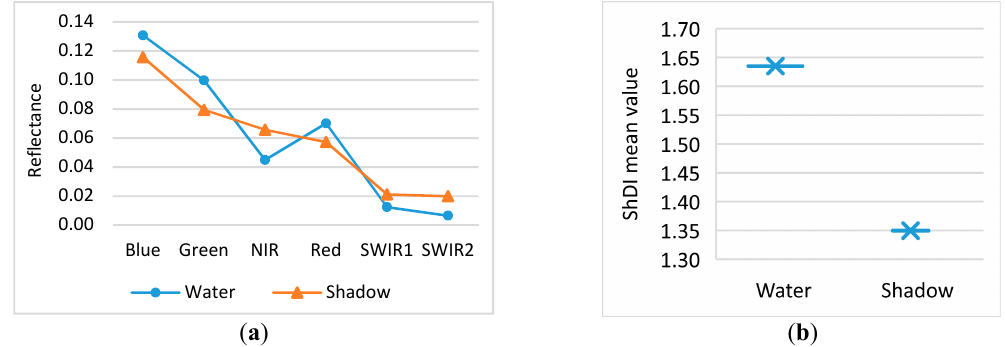
Figure 7. Reflectance of surface water and shadow in the Hong Kong study area: ( a ) band reflectance and ( b ) proposed shadow index (ShDI).